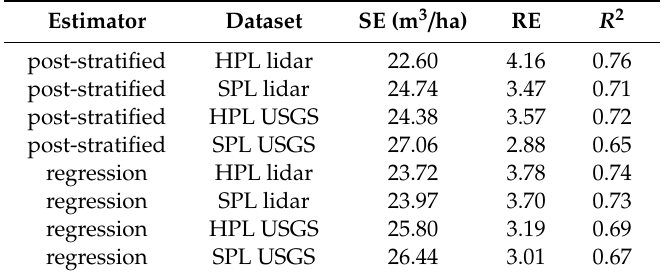
Table 1. Measures of e ffi ciency for various estimation strategies, n = 191